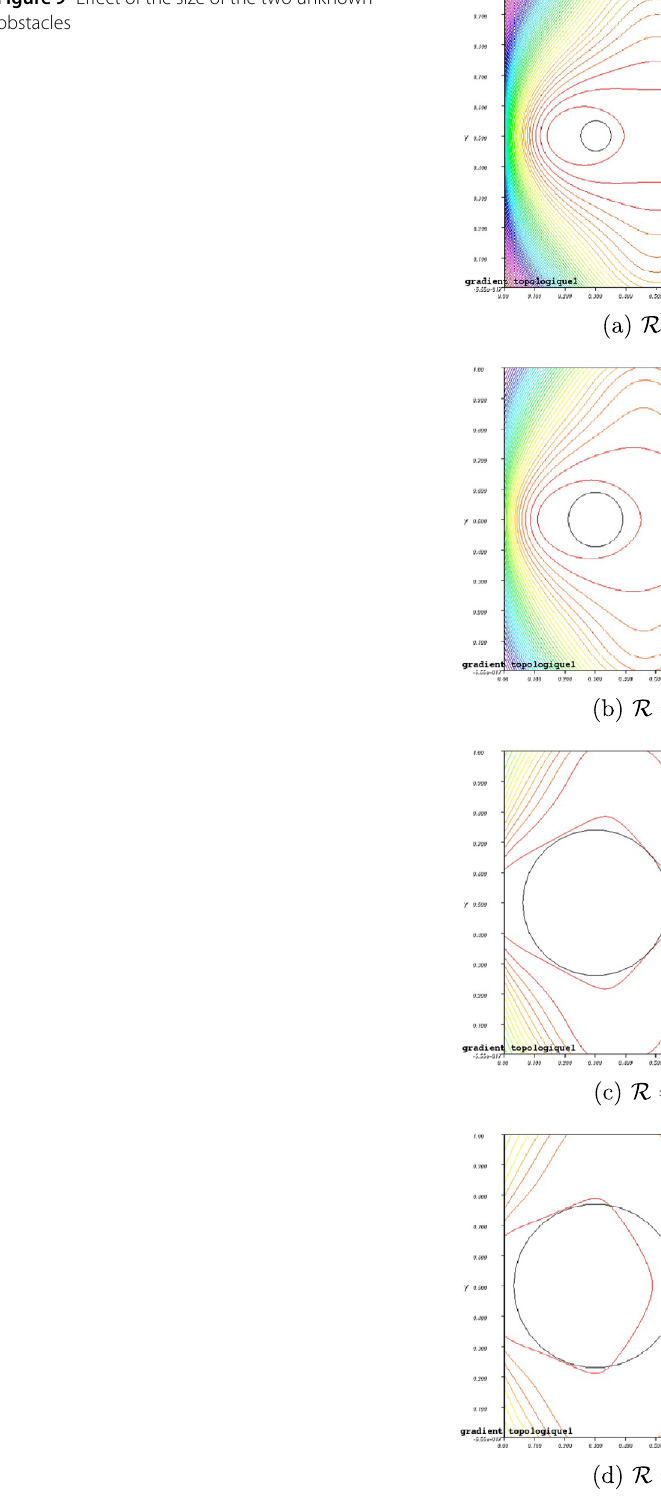
Figure 9 Effect of the size of the two unknown